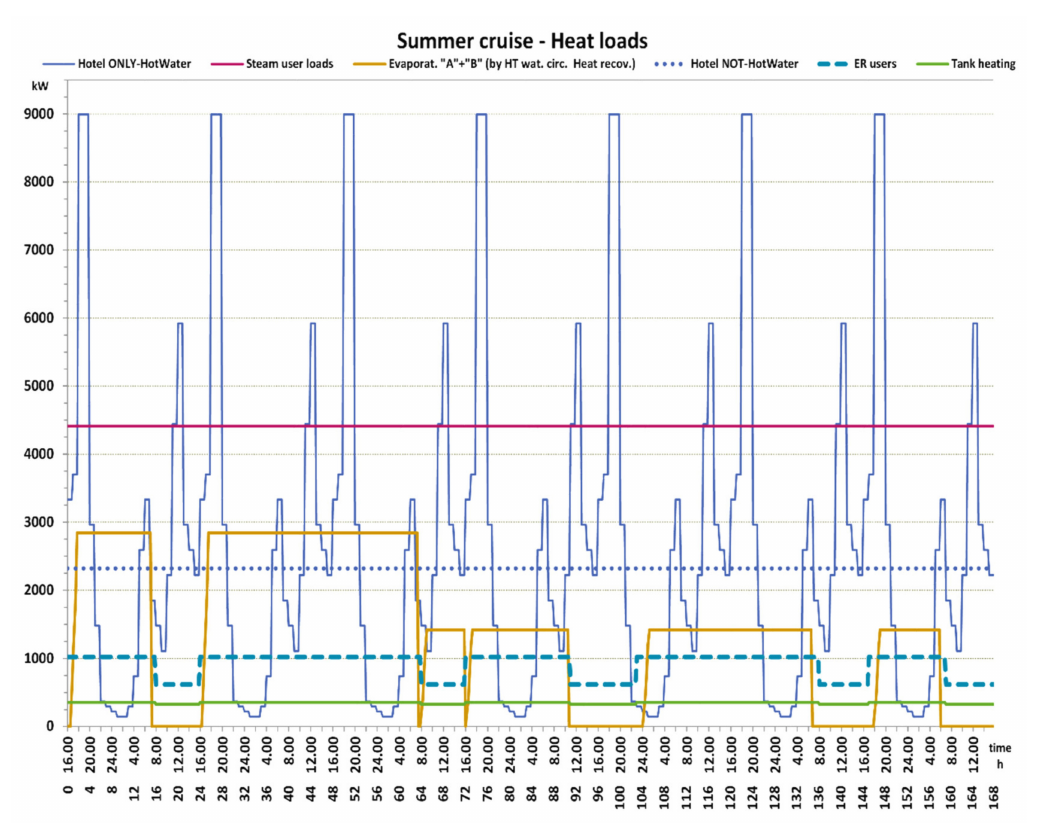
Figure 4. Thermal demand during the summer